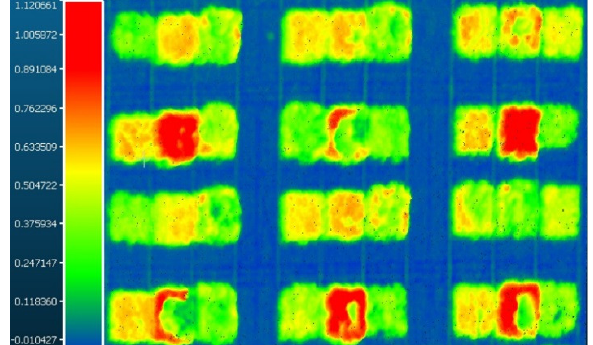
Figure 4. Canopy height (m) within the canopy height model (CHM) with nadir top view The CHM was rasterized with a spatial resolution of 0.01m. For further calculation the maximal height value for each grid cell was